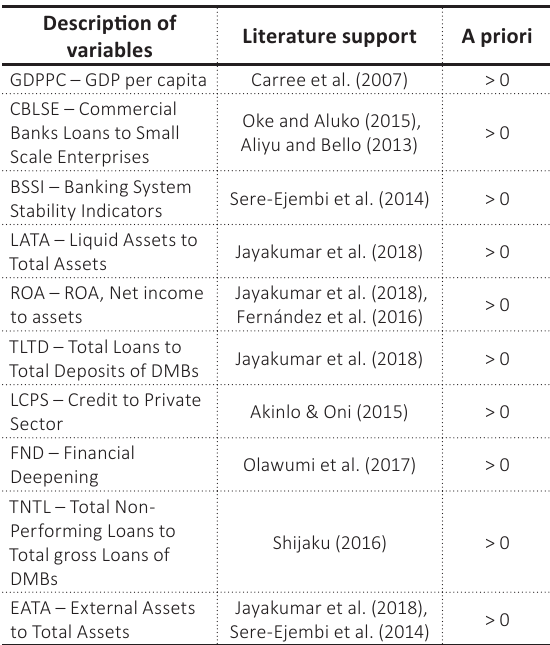
Table 1. Description of variables,